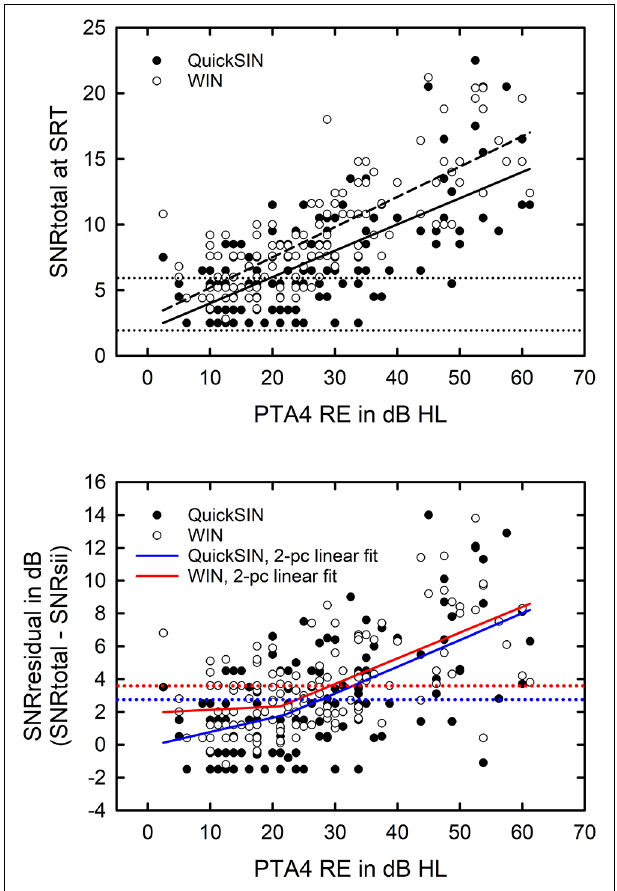
FIGURE 6 | The top panel shows the measured signal-to-noise ratio (SNR), SNRtotal, for the QuickSIN (filled circles), and the WIN (unfilled circles) for the 137 older adults in this study plotted as a function of the pure-tone-average for 500, 1,000, 2,000, and 4,000 Hz in the right ear (PTA4 RE). The sloping solid and dashed lines are the best-fitting linear-regression solutions for the QuickSIN (solid; r = 0.68) and WIN (dashed; r = 0.78). Assuming a mean SNR at SRT for young normal-hearing adults of +4 dB and a standard deviation (SD) of 2 dB for both tests, the dotted horizontal lines represent ± 1 SD boundaries for these norms. The bottom panel plots the difference, SNRresidual, between the measured SNRs at SRT, SRTtotal, in the top panel and the SNR at SRT predicted by the SII from the hearing loss, SNRsii, plotted as a function of PTA4 RE. The best-fitting two-piece linear fits for SNR residual are plotted for the QuickSIN (blue solid; r = 0.59) and WIN (red solid; r = 0.61). The dotted horizontal lines represent the upper bound of the 95% confidence interval from test-retest measures for each test, 2.7 dB for the QuickSIN (blue dotted line), and 3.6 dB for the WIN (red dotted line).